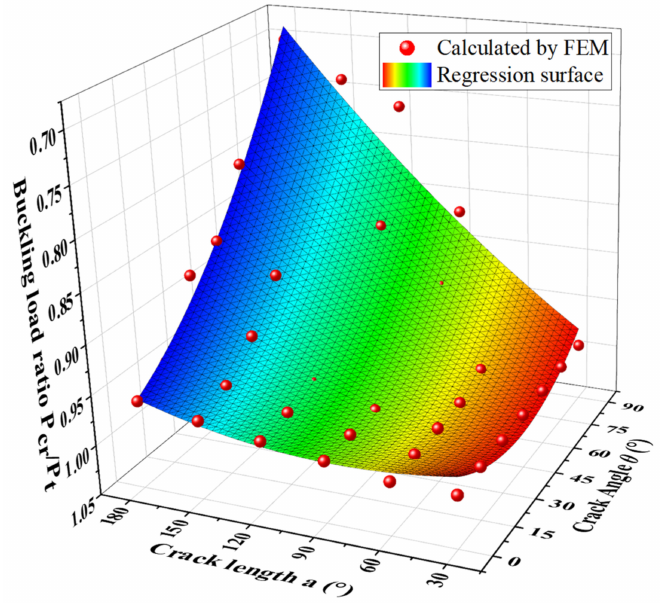
Figure 20. Relation of elastic-plastic buckling of cracked cylindrical shell with clamped support ( L / R = 20, R / T =